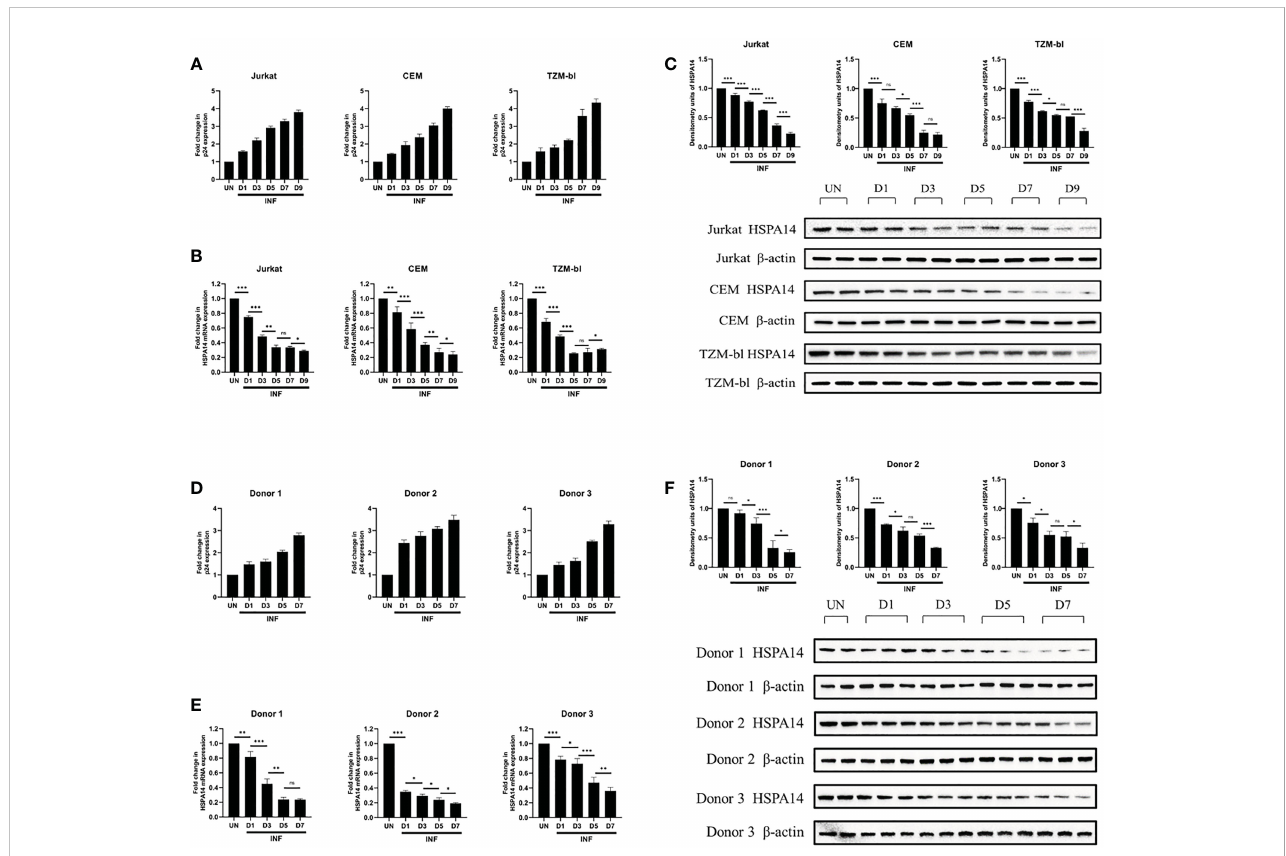
FIGURE 2 HSPA14 is down modulated during HIV-1 infection. (A, D) The expression of viral capsid protein p24 mRNA was measured to monitor the progression of infection. (B) mRNA expression pro fi ling of HSPA14 during HIV infection. Different cells were infected with HIV pseudovirus and were harvested on day 1 (D1), day 3 (D3), day 5 (D5), day 7 (D7) and day 9 (D9), post infection for quantitative real time PCR analysis. (C) Representative western blot and densitometry analysis showing expression pro fi le of HSPA14 in HIV pseudovirus infected cells at different time points. (E) mRNA expression pro fi ling of HSPA14 during HIV infection. Different cells were infected with HIV pseudovirus and were harvested on day 1 (D1), day 3 (D3), day 5 (D5) and day 7 (D7), post infection for quantitative real time PCR analysis. (F) Representative western blot and densitometry analysis showing expression pro fi le of HSPA14 in HIV pseudovirus infected CD4+T cells at different time points. CD4+T cells were isolated from PBMC of three healthy donors and were infected with HIV pseudovirus. The error bars are presented as the mean ± SD values and signi fi cance is de fi ned as *P ≤ 0.05, **P ≤ 0.01 and ***P ≤ 0.001. INF: Infected with HIV-1. UN,